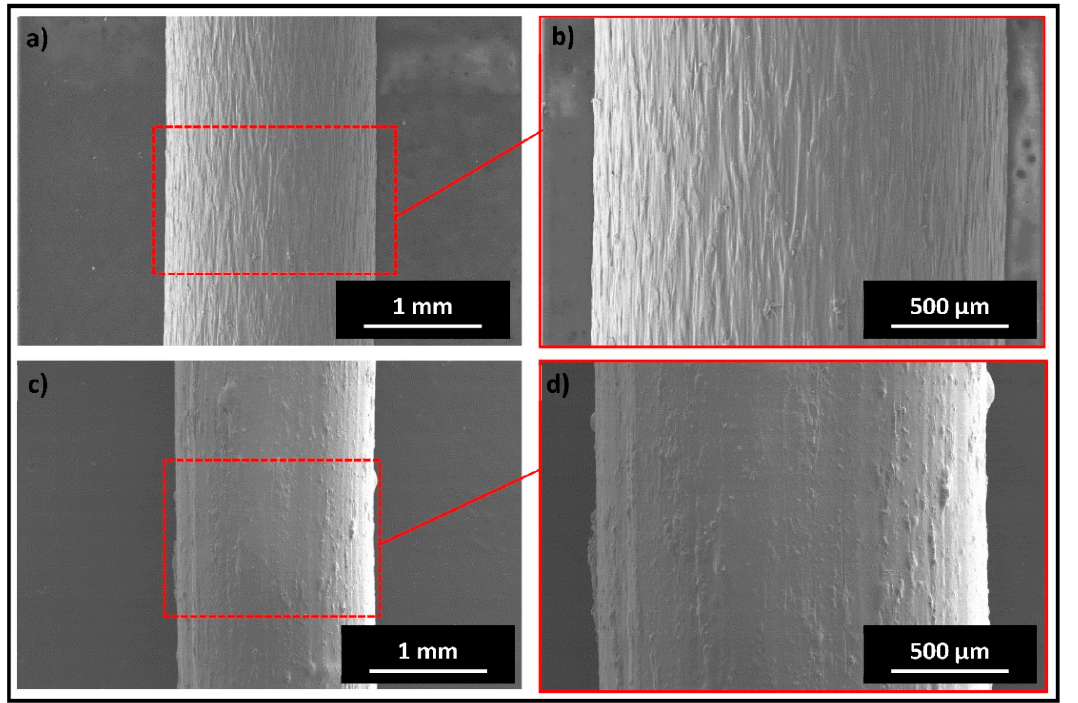
Figure 3. SEM images of PLA filament at ( a ) low and ( b ) high magnification and TCP–PLA filament at ( c ) low and ( d ) high magnification. (The scale bar represents the actual length).